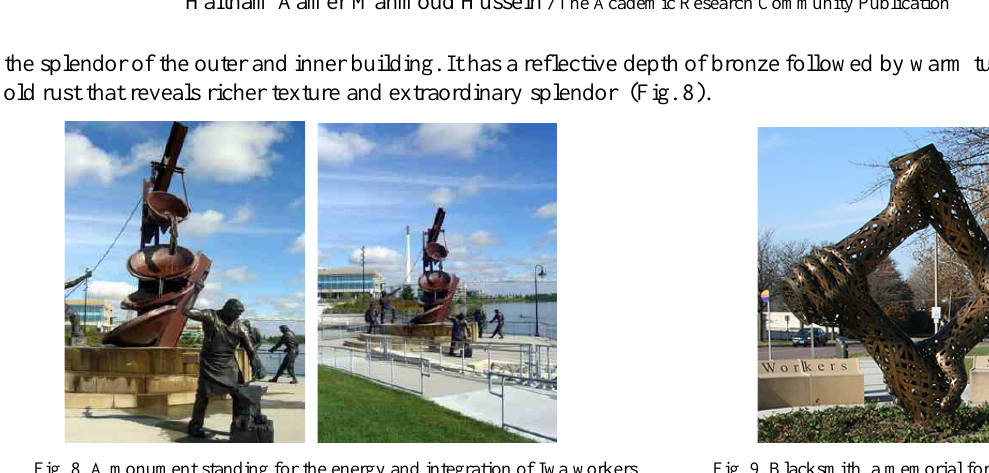
Fig. 10, A Statue of Two oil industry workers in the Almetyevsk Republic of Tatarstan Russia